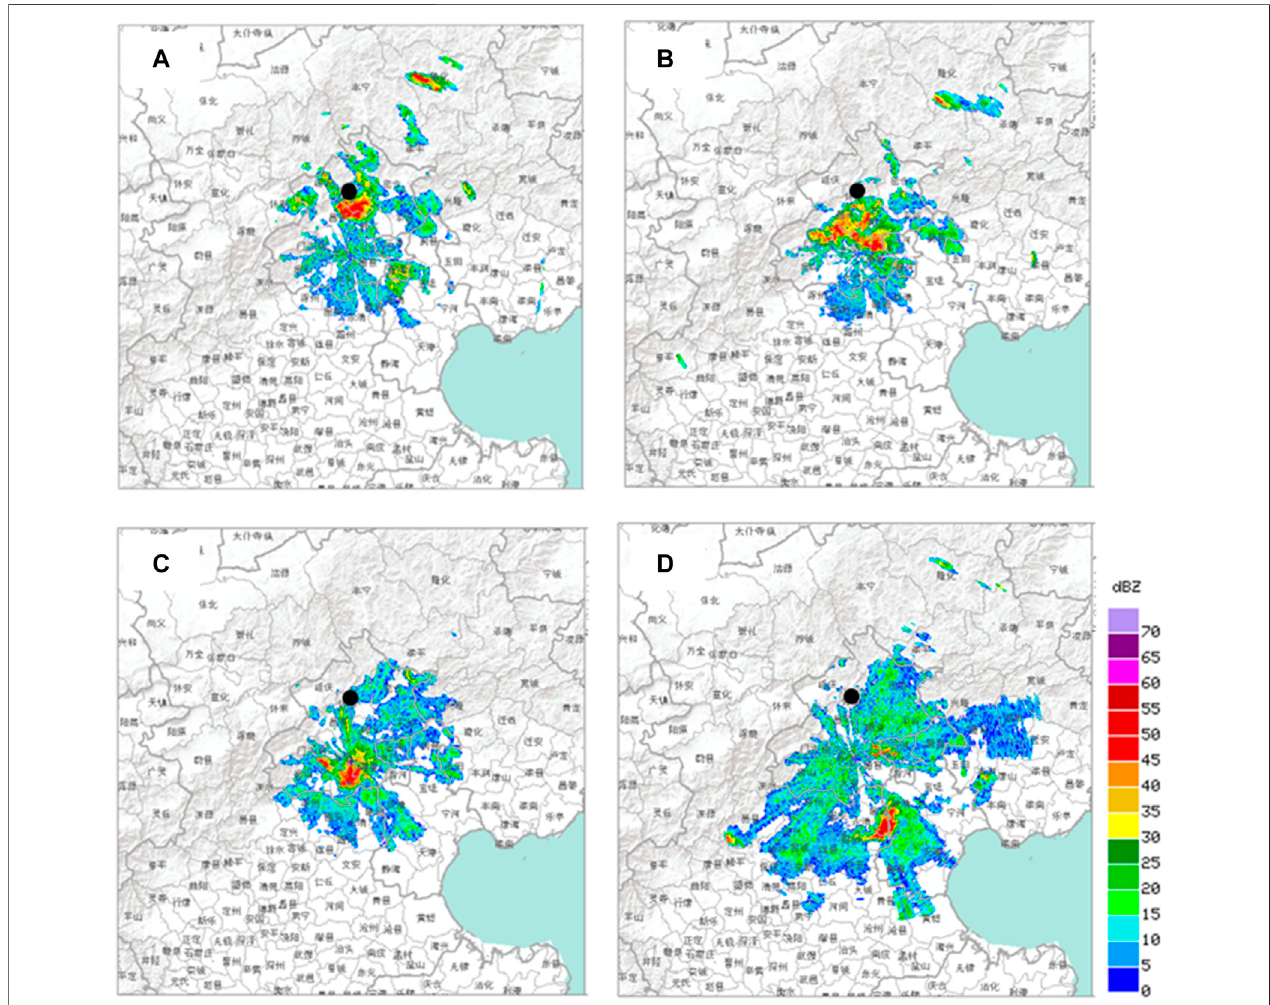
FIGURE 1 | Observed radar re fl ectivity (unit: dBZ) at (A) 1000 UTC, (B) 1100 UTC, (C) 1200 UTC, and (D) 1300 UTC on 9 August 2021.